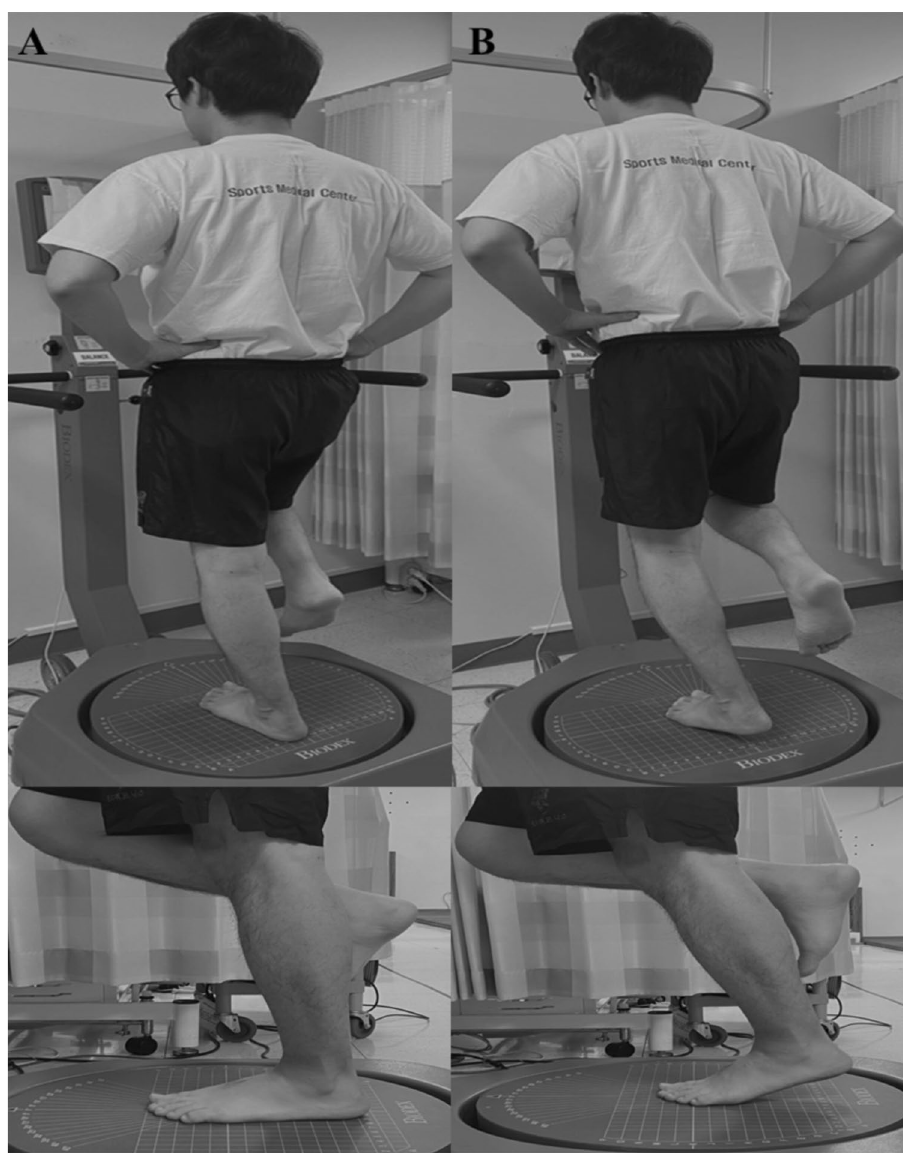
Figure 1. Static postural stability test position. The conventional static postural stability test ( a ) and modified static postural stability test ( b ).